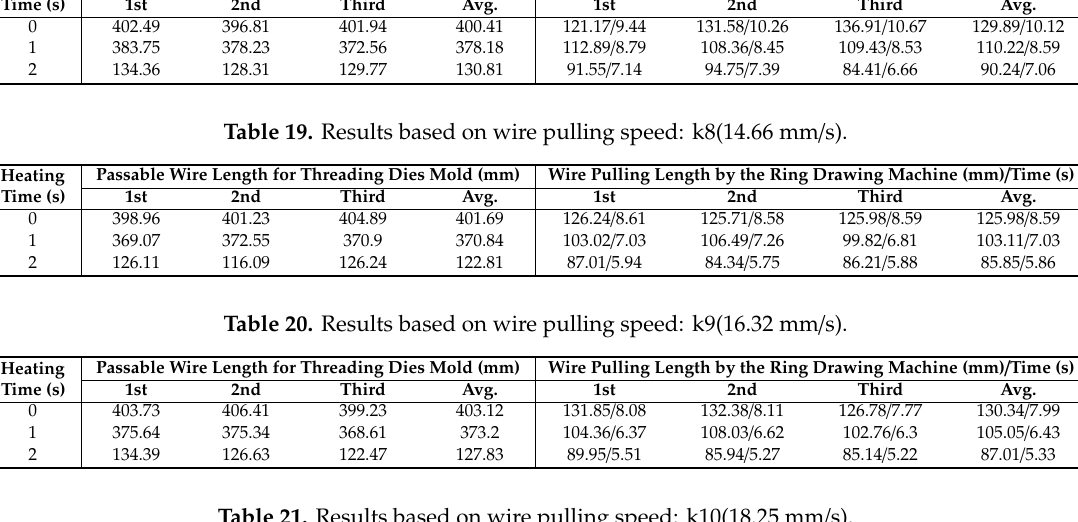
Table 21. Results based on wire pulling speed: k10(18.25 mm / s).